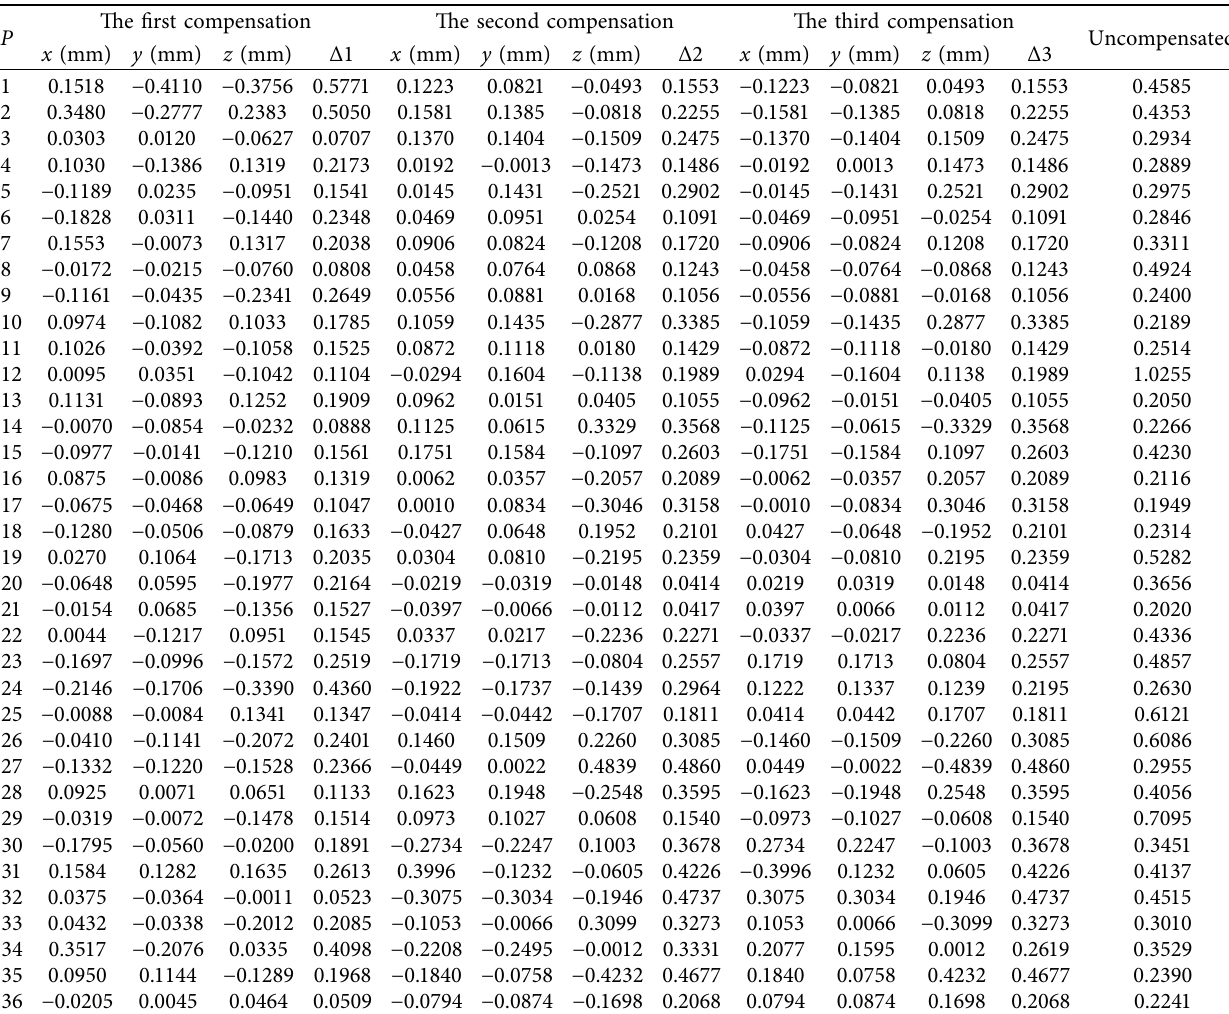
Table 5: Error without alternative trajectory and error after changing the trajectory three